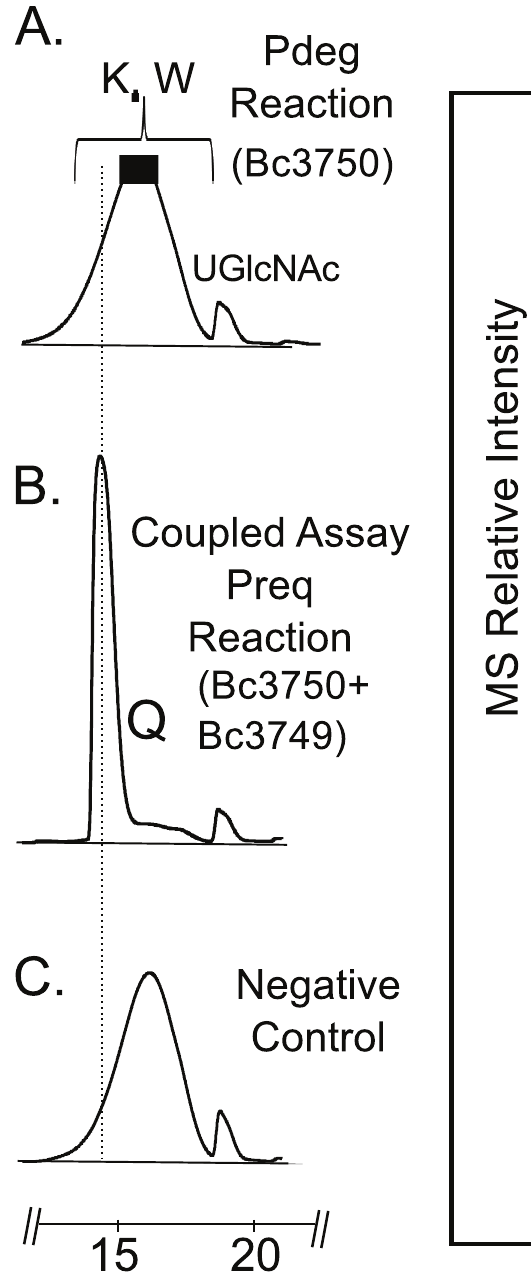
Fig 6. Analysis of Preq recombinant enzyme reaction by UV-HPLC and LC-ESI-MS-MS. A. Pdeg reaction shows the conversion of UDP-GlcNAc to UDP-4-keto-6-deoxy-HexNAc before recombinant Preq addition. B. Following Pdeg reaction, purified Preq was added and reacted with UDP-4-keto- 6-deoxy-GlcNAc in the presence of NADPH to give product Q, UDP-QuiNAc, with m/z 590 and ms/ms of 402.94, 384.93, and 304.98 (Boxed top and second panel) C. Preq negative control reaction carried out with unrelated